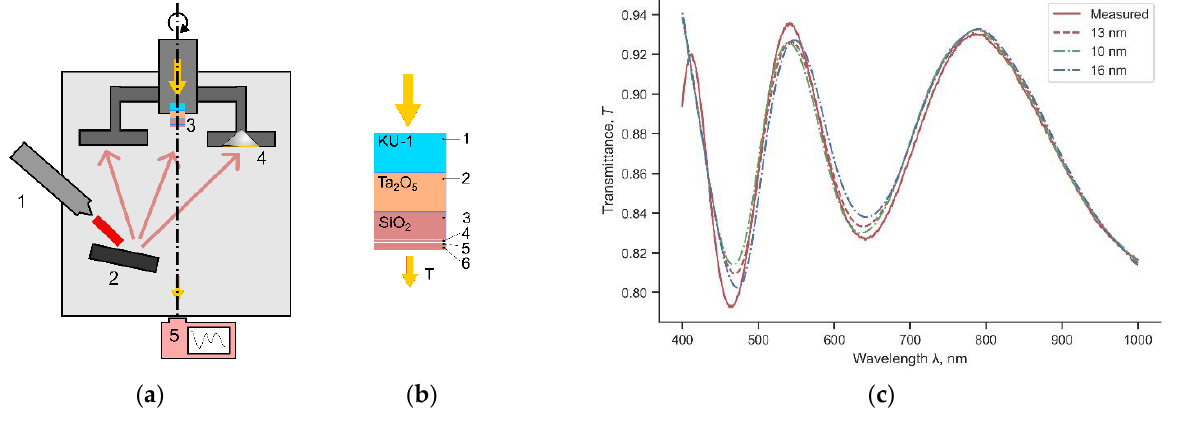
Figure A1. ( a ) The schematic of the thin-film sputtering chamber and optical control unit: ion gun (1) irradiates target (2); the dispersed substance is deposited on control sample (3) and SPR prism (4) fixed on the rotating carousel. The sputtering thickness is monitored with a spectrometer (5). ( b ) The final layout of the sprayed layers on the control sample: 1 — KU-1 glass; 2 — pre-sprayed Ta 2 O 5 layer; 3 — pre-sprayed SiO 2 layer; 4, 5, and 6 — SiO 2 coatings. ( c ) An example of the measured trans- mission spectrum of the control sample for coating thickness (red solid line) and a model approxi- mation for 13 nm coating thickness (dashed line), and model approximations within a confidence interval of 10 – 16 nm (dot-dashed lines).